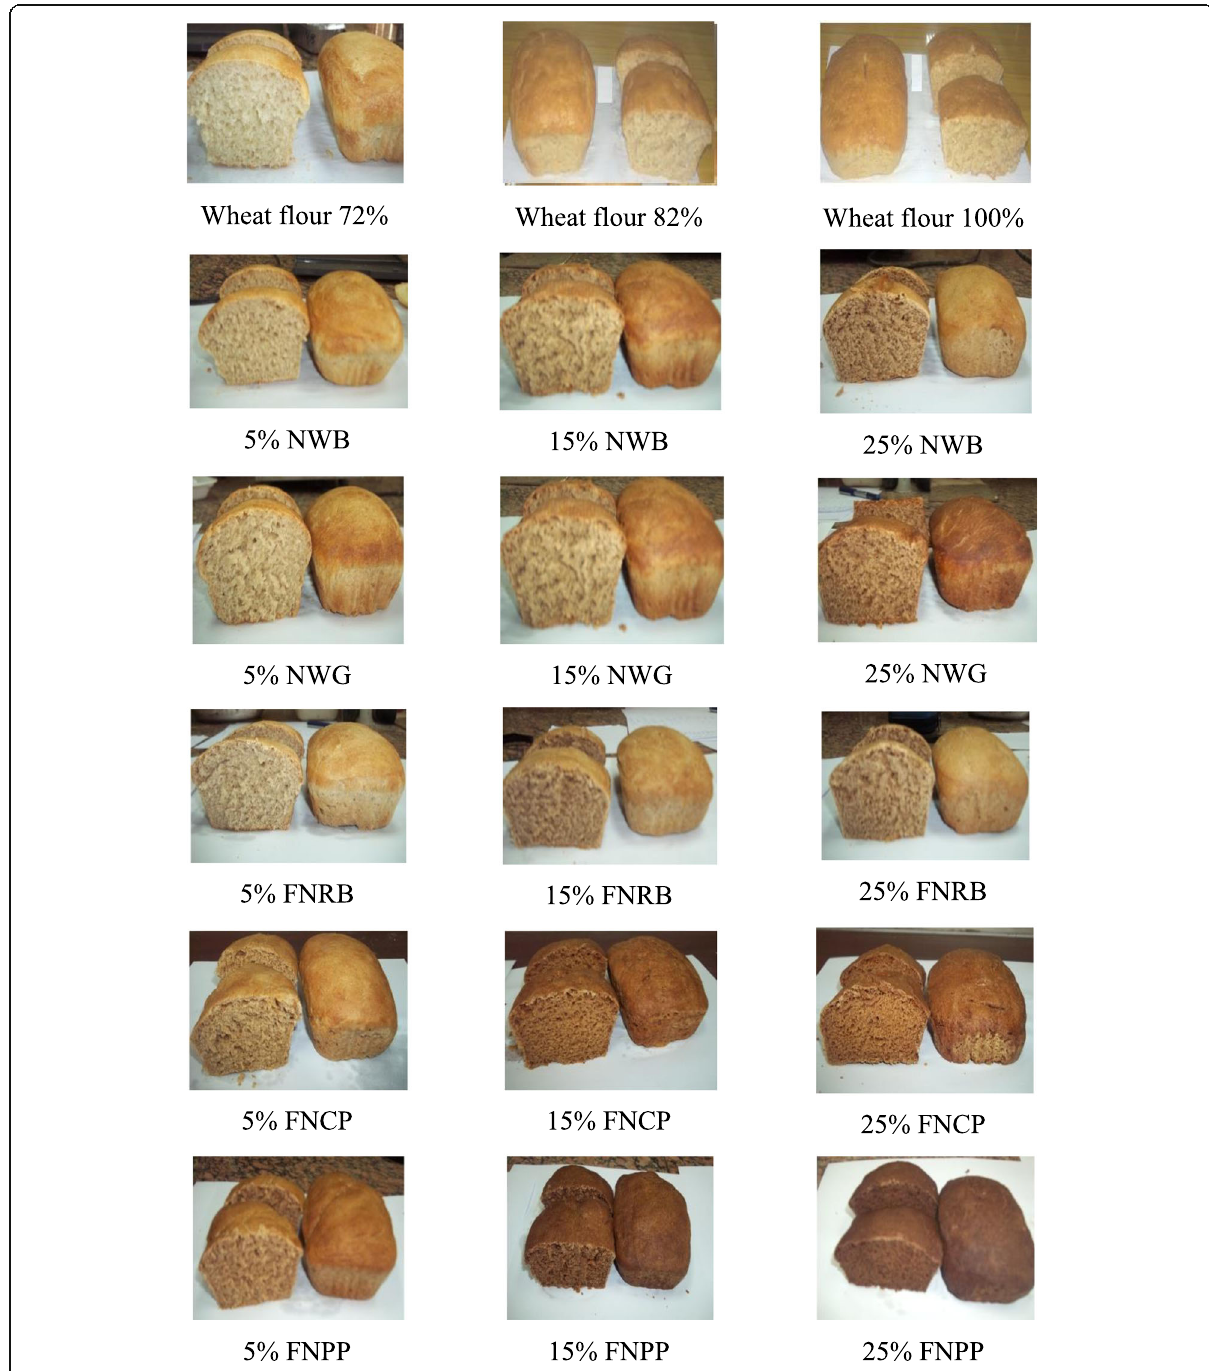
Fig. 2 Photographs of pan bread as affected by addition of nano and fermented nano materials. NWB, nano wheat bran; NWG, nano wheat germ; FNRB, fermented nano-rice bran; FNCP, fermented nano-carrot pomace; and FNPP, fermented nano-pomegranate